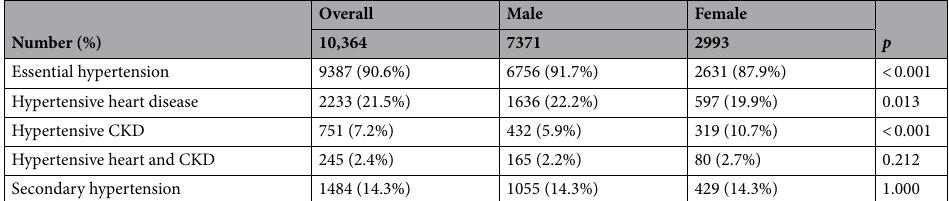
Table 3. Distribution in diagnostic codes of hypertension among children and adolescents according to ICD-9-CM. CKD chronic kidney disease, ICD-9-CM International Classification of Diseases, Ninth Revision, Clinical